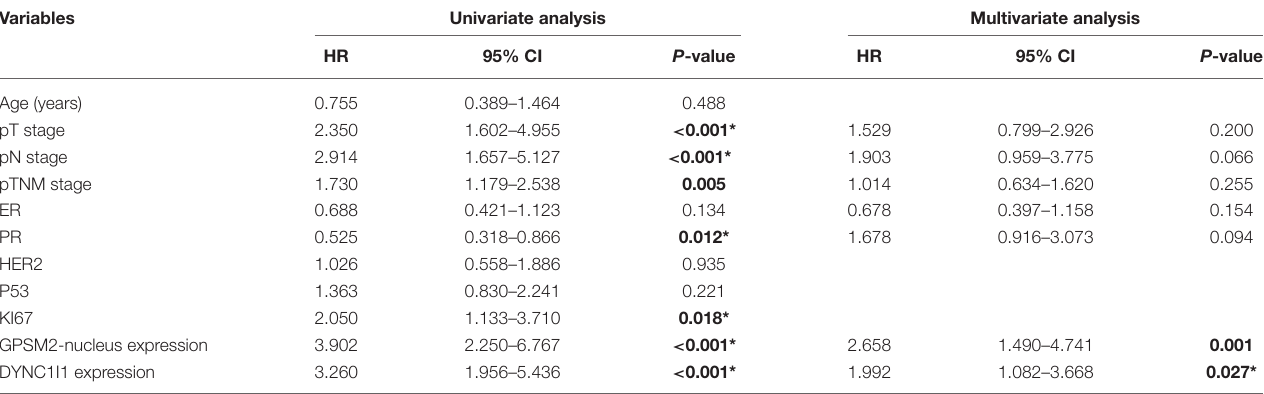
TABLE 3 | Cox regression analysis of overall survival in breast cancer